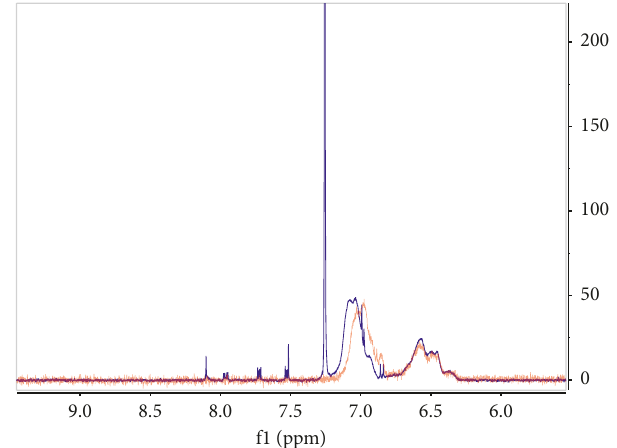
Figure 3: NRM spectra of a lip gloss sample. The blue 1 H NMR spectra show the signals of a direct measurement in cyclohexane/ acetone-d 6 , while the red spectra represent the result of the same sample following SPE cleanup. The interfering signals in the range 8.2–7.2 ppm are completely removed.